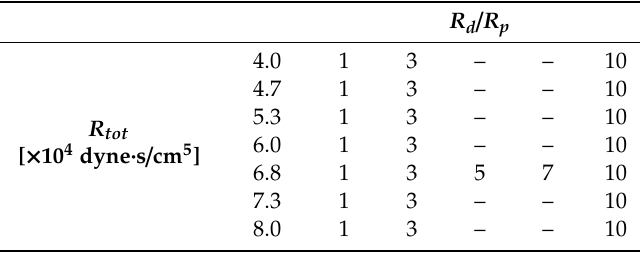
Table 1. R tot and R d / R p used in the computational fluid dynamics (CFD)